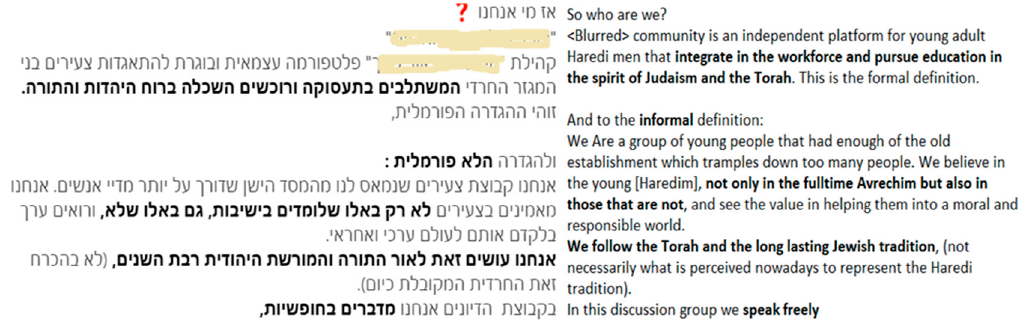
Figure 3. Excerpt from a communal discussion group of young working Haredi men.